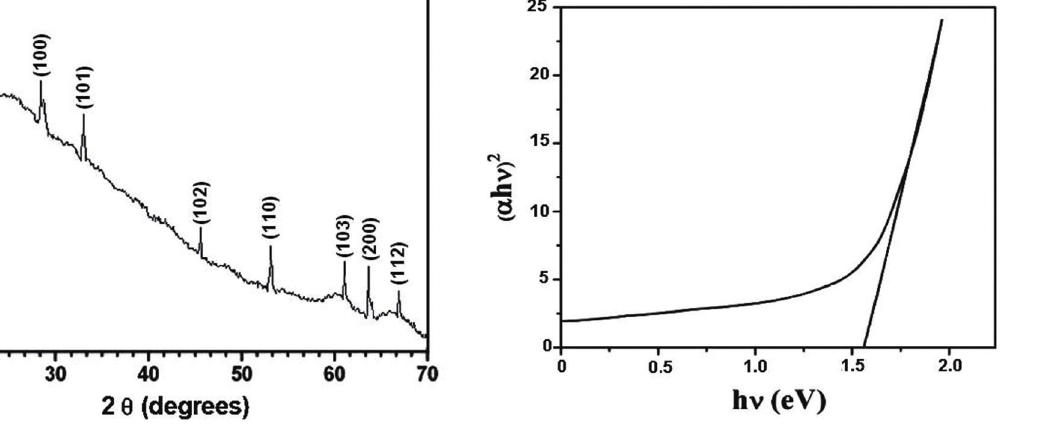
Figure 1: XRD spectrum of CoS thin films.